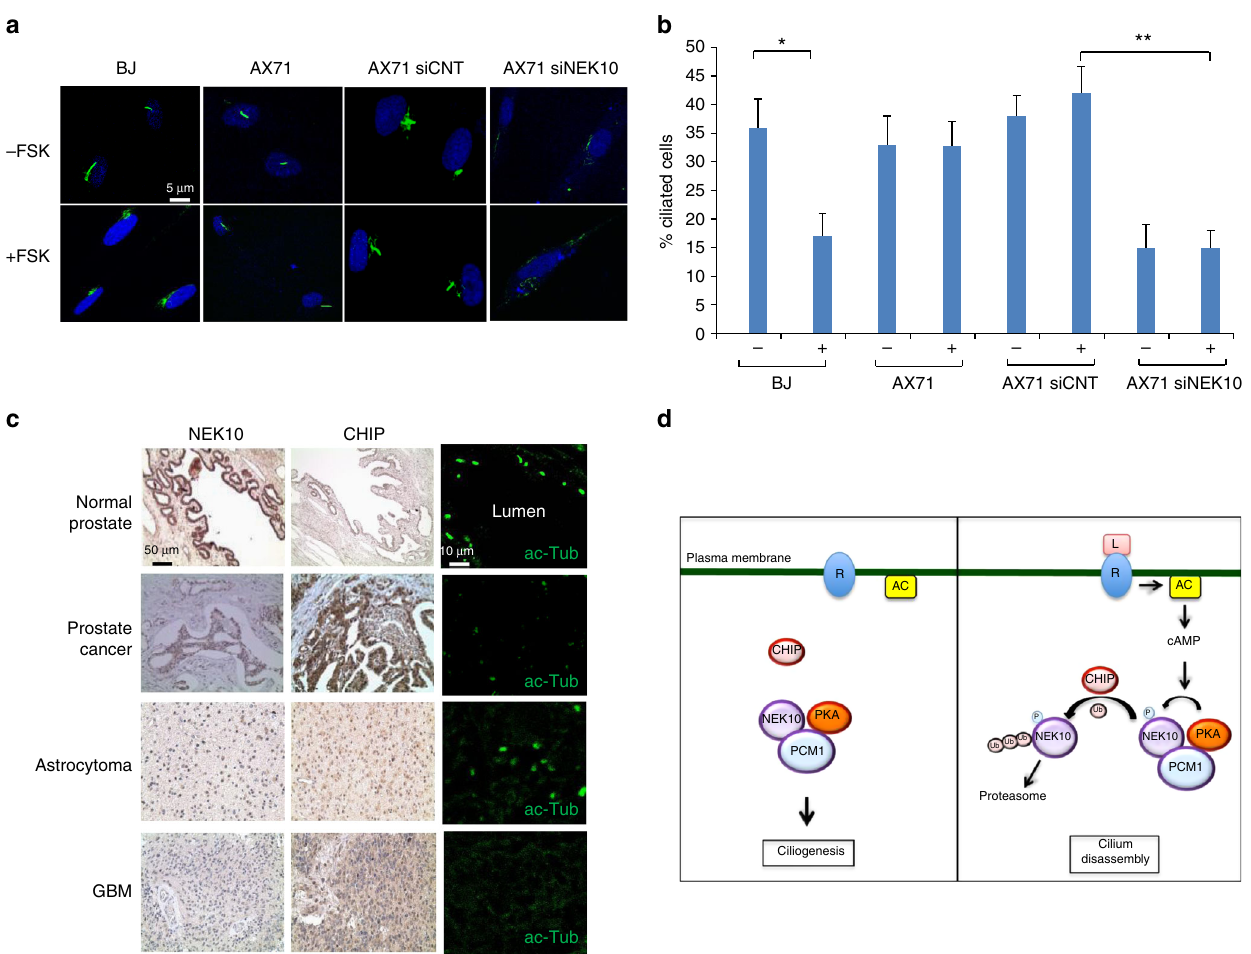
Fig. 7 CHIP, NEK10 and cilia in SCAR16 fi broblasts and cancer tissues. a Skin fi broblasts from healthy volunteers (BJ) and SCAR16 patients (AX71) were serum deprived for 48 h and treated with FSK (80 µ M/6 h). Cells were fi xed and stained for acetylated tubulin and Draq5. Where indicated, AX71 cells were transiently transfected with siRNA targeting endogenous NEK10, before stimulation. b Cumulative data from four independent experiments are shown. For each group a minimum of 25 cells/experiment was averaged. * p < 0.05; ** p < 0.01. c Immunohistochemistry for NEK10, CHIP, and acetylated tubulin of the following tissue sections: prostate (normal tissue and high-grade cancer) and glial tumors (astrocytoma and glioblastoma). A total of 8 prostate and 6 glial tumor tissue speciments were analyzed. d Schematic depiction of the proposed model: In growth-arrested cells, NEK10 positively contributes to ciliogenesis. Stimulation of adenylate cyclase (AC) by e.g., a de fi ned GPCR ligand increases cAMP levels and activates PKA.